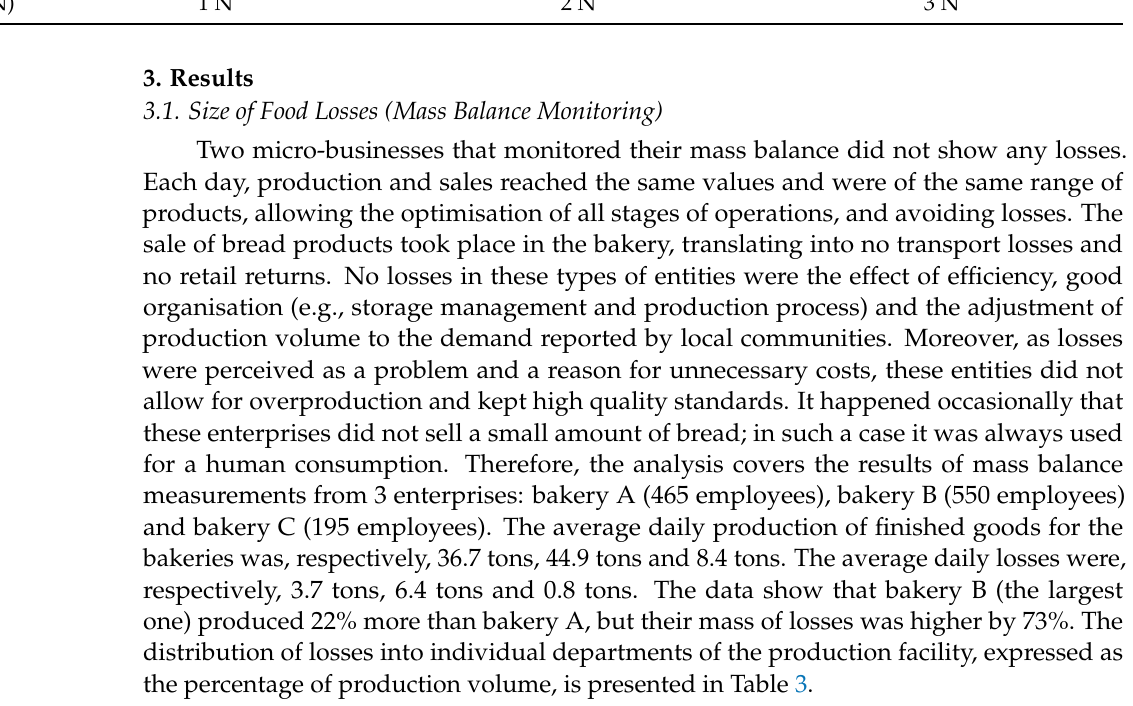
Table 2. Significance level matrix and probability of occurrence of food losses risk in baking and confectionery industry. Risk Significance Level Insignificant; Probability Causes Minor Losses, Difficult Moderately Significant; It Is to Eliminate, Resulting from Possible to Limit the Risk Production Technology Predictable (P) Unpredictable